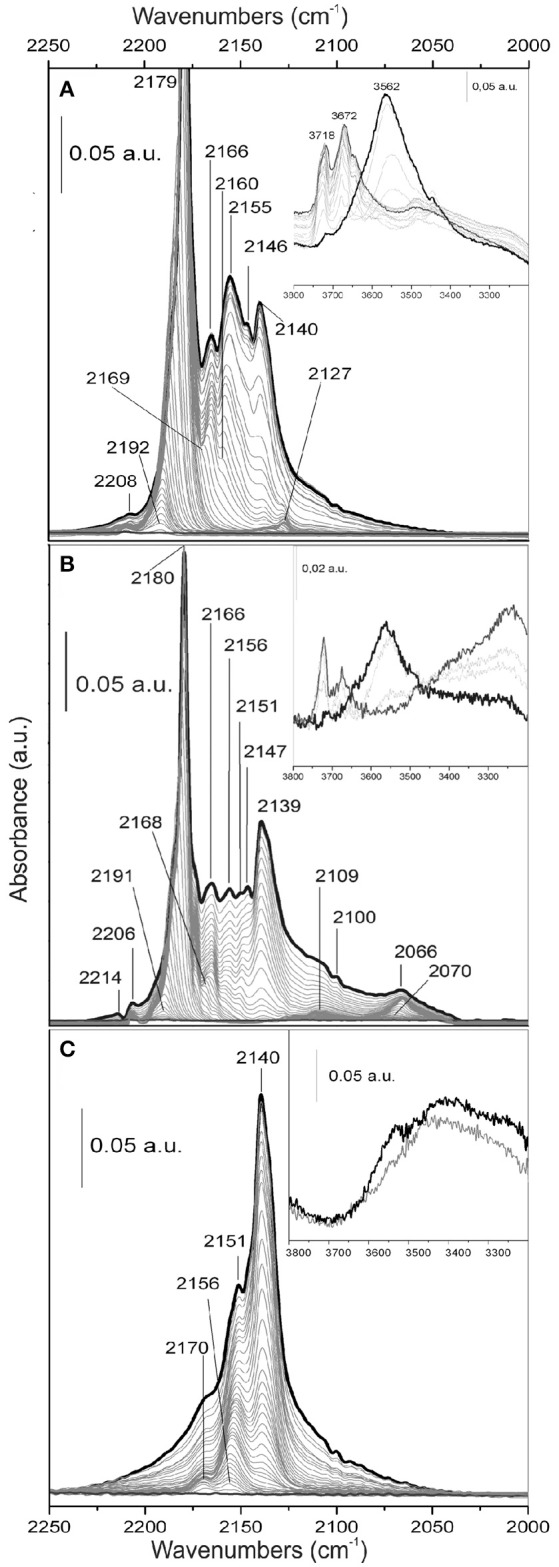
FTIR spectra of CO adsorbed at 77 K on the surface of: (A) TiO2; (B) MoS2/TiO2; (C)
p-C2H2/MoS2/ TiO2. In the insets, the hydroxyl groups region is shown.